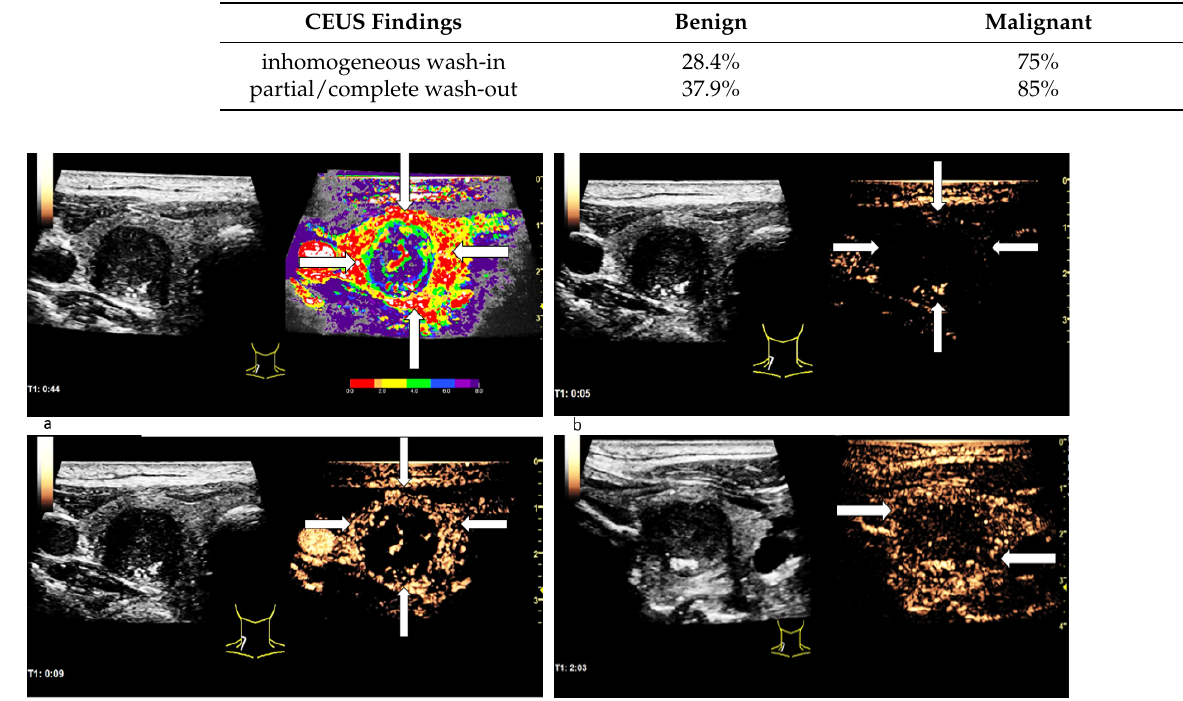
Figure 4. Patient with thyroid carcinoma. In the parametric colour-coded CEUS mode ( a ) the margins of the lesion (white arrows) are mainly covered in red and orange. The center of the lesion as well as the normal thyroid gland are primarily coloured in purple with small parts of blue and green. This suggests that SonoVue first expands along the carcinoma’s margins. The CEUS examination 5 s after the bolus injection ( b ) shows no contrast agent expansion yet neither marginally (white arrows) nor centrally. 9 s after the bolus injection ( c ) the contrast enhancement has begun: Microbubbles first expand along the lesion’s margins (white arrows). In the CEUS recording, taken 2 min after bolus injection ( d ), a decrease of contrast enhancement called wash-out along the carcinoma’s margins (white arrows) can be spotted.